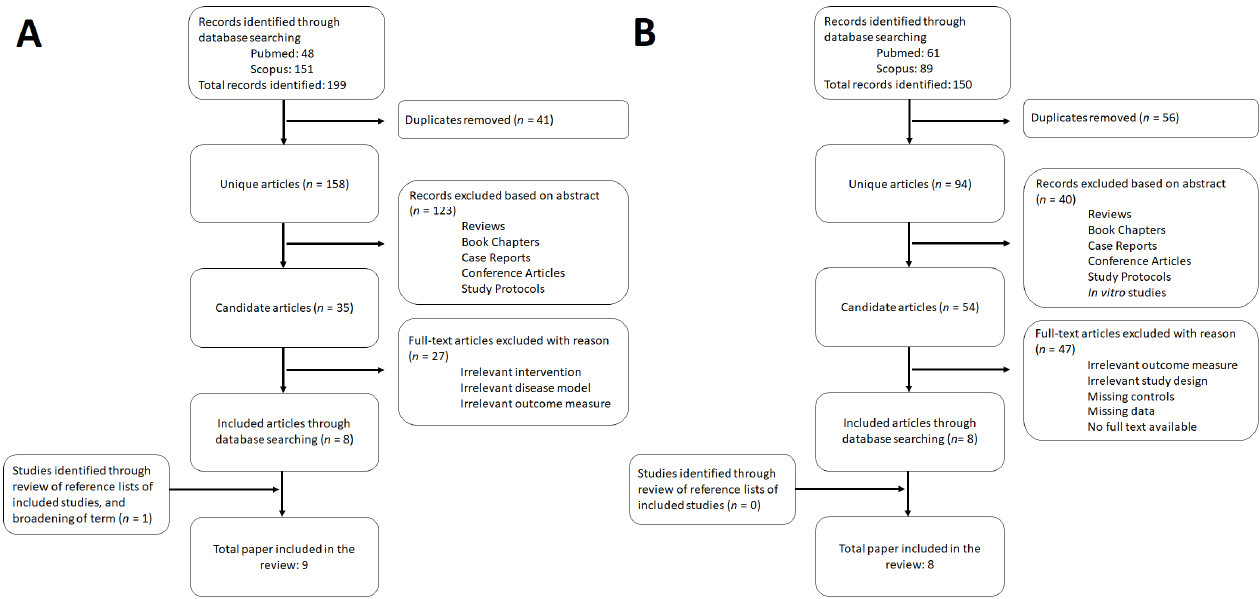
Figure 1. Flow diagram of ( A ) the identified, screened, and included studies on the effect of pro-, pre-, and synbiotics on muscle wasting [12,13,14,15,16,17,18,19,20,21] and ( B ) on the relationship between gut permeability and muscle wasting [15,16,20,22,23,24,25,26].